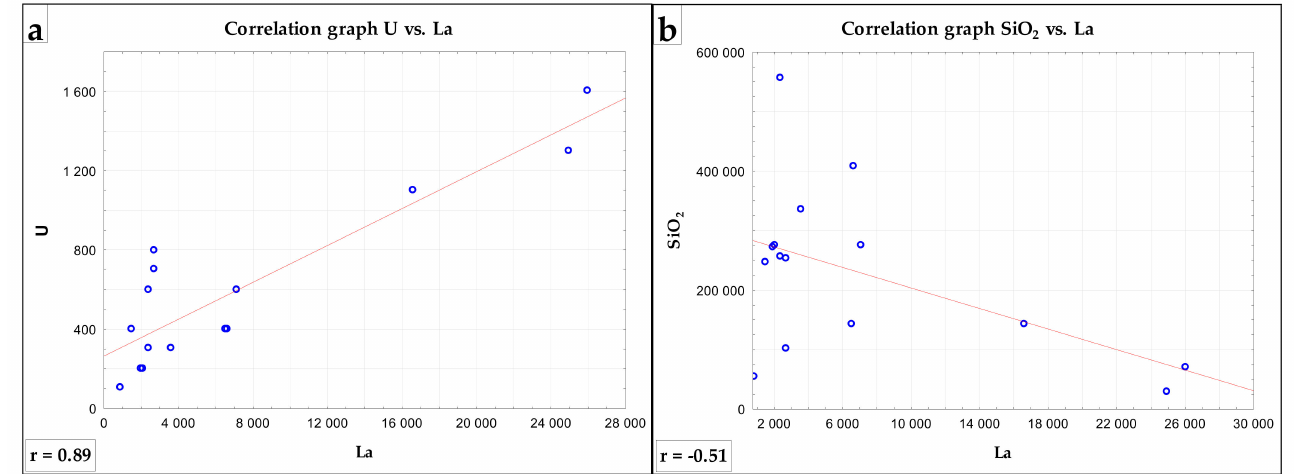
Figure 9. Correlation graphs: positive correlation U vs. La ( a ) and negative correlation SiO 2 vs. La ( b ) ( n =